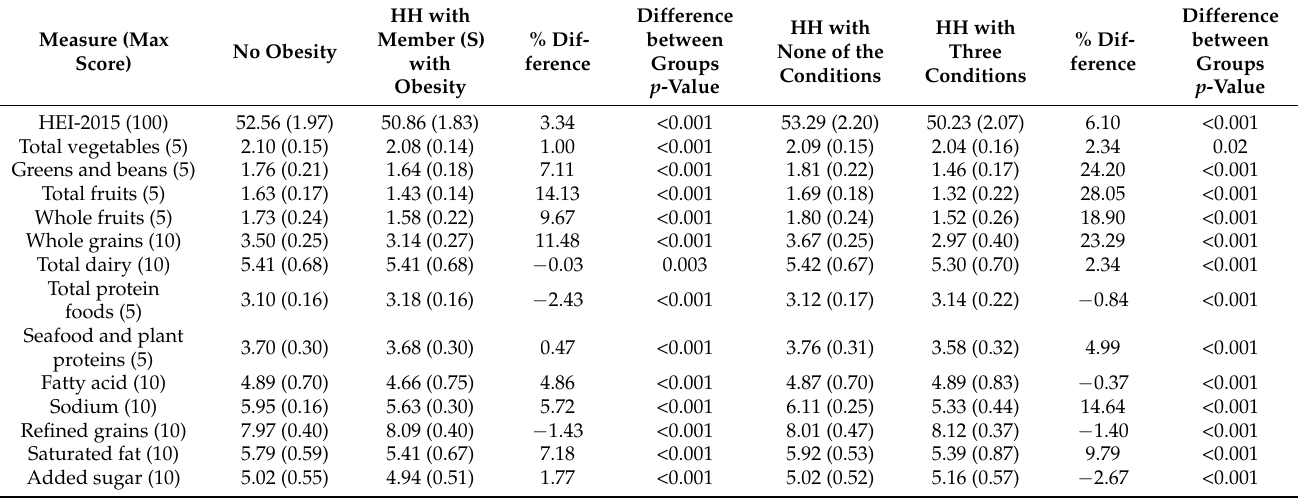
Adjusted for household poverty level, size, race, and ethnicity; household head’s age and marital status; and female-led household. Note: Unadjusted measures are omitted for brevity but can be obtained from the authors upon